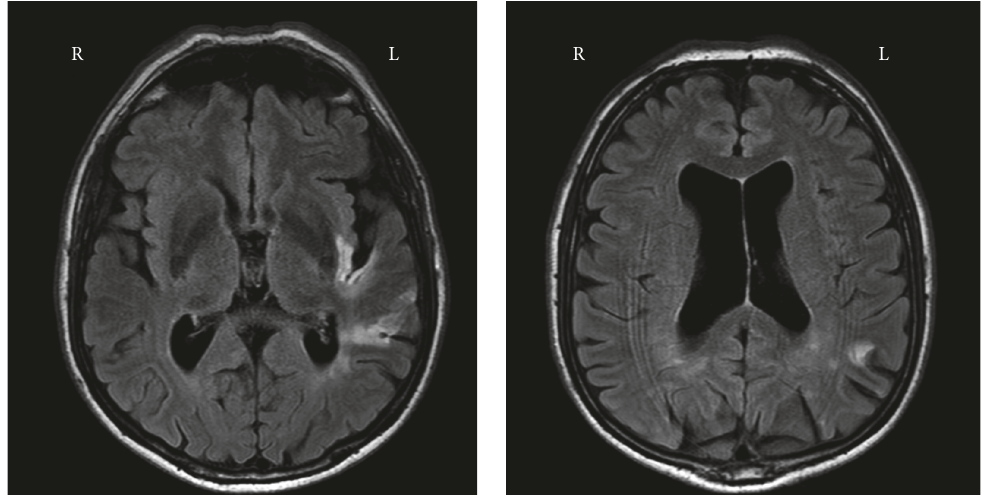
Figure 1: Transversal fluid attenuated inversion recovery (FLAIR) images of the patient, revealing a lesion to the posterior part of the insula and part of the left temporal cortex and left parietal cortex.